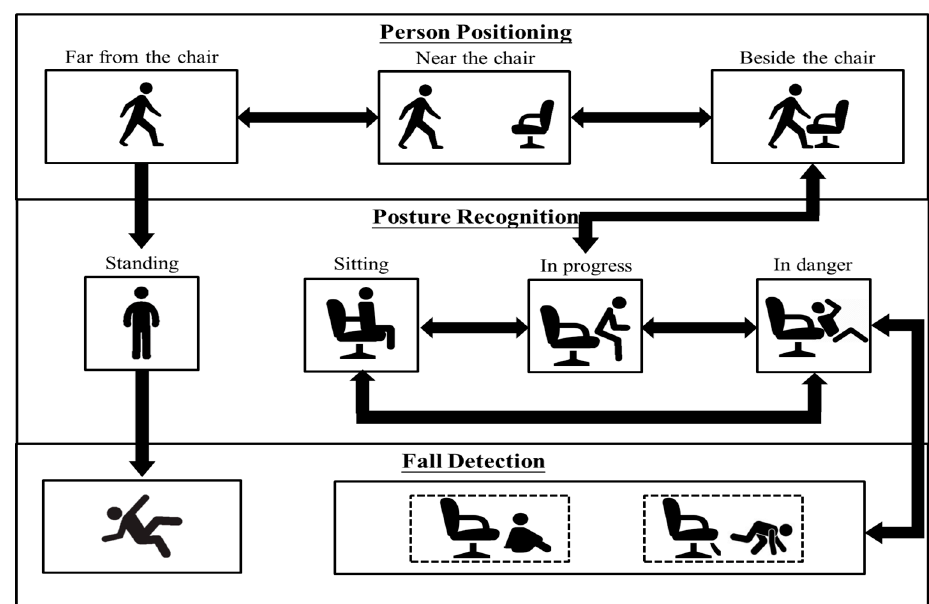
Figure 1. System architecture of the Image-based FAll Detection System (IFADS).